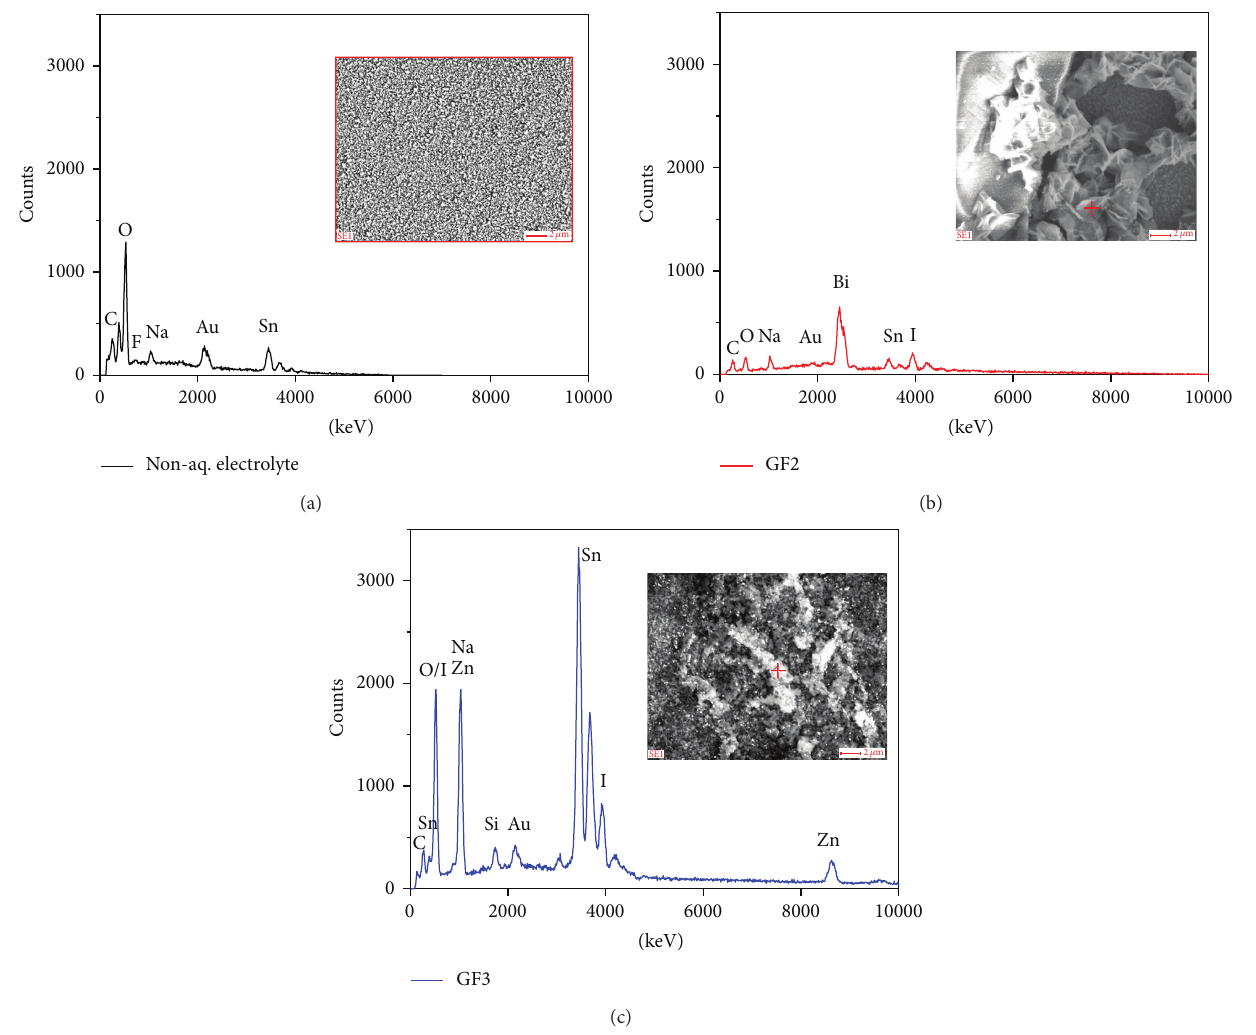
Figure 6: EDX spectra of precipitates on TCO after evaporation of electrolyte. Samples were sputtered with Au to increase conductivity. (a) Area analysis as indicated from the SEM inset of nonaqueous electrolyte precipitate. Sn, O, and F originate from the TCO substrate. C and Na are trace amounts from the electrolyte. (b) Spot analysis of precipitate from cell with 10wt% H 2 O-containing electrolyte in contact with GF2. Bi and I are detected due to GF2 and electrolyte interaction. (c) Spot analysis of precipitate from cell with 10wt% H 2 O-containing electrolyte in contact with GF3. Zn and I are detected due to GF3 and electrolyte interaction. Si is detected due to increased acceleration voltage, so the soda-lime glass was reached by the electron